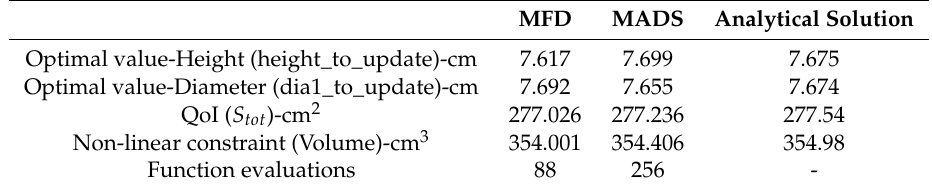
Figure 2. Workflow of the problem setup using the proposed cloud-based framework. Table 2. Outcome comparison of the gradient-based method (MFD [34,35]) and the derivative-free method (MADS [36]). In the table, MFD refers to the gradient-based method (same as MFD-1 in Table 1), and MADS refers to the derivative-free